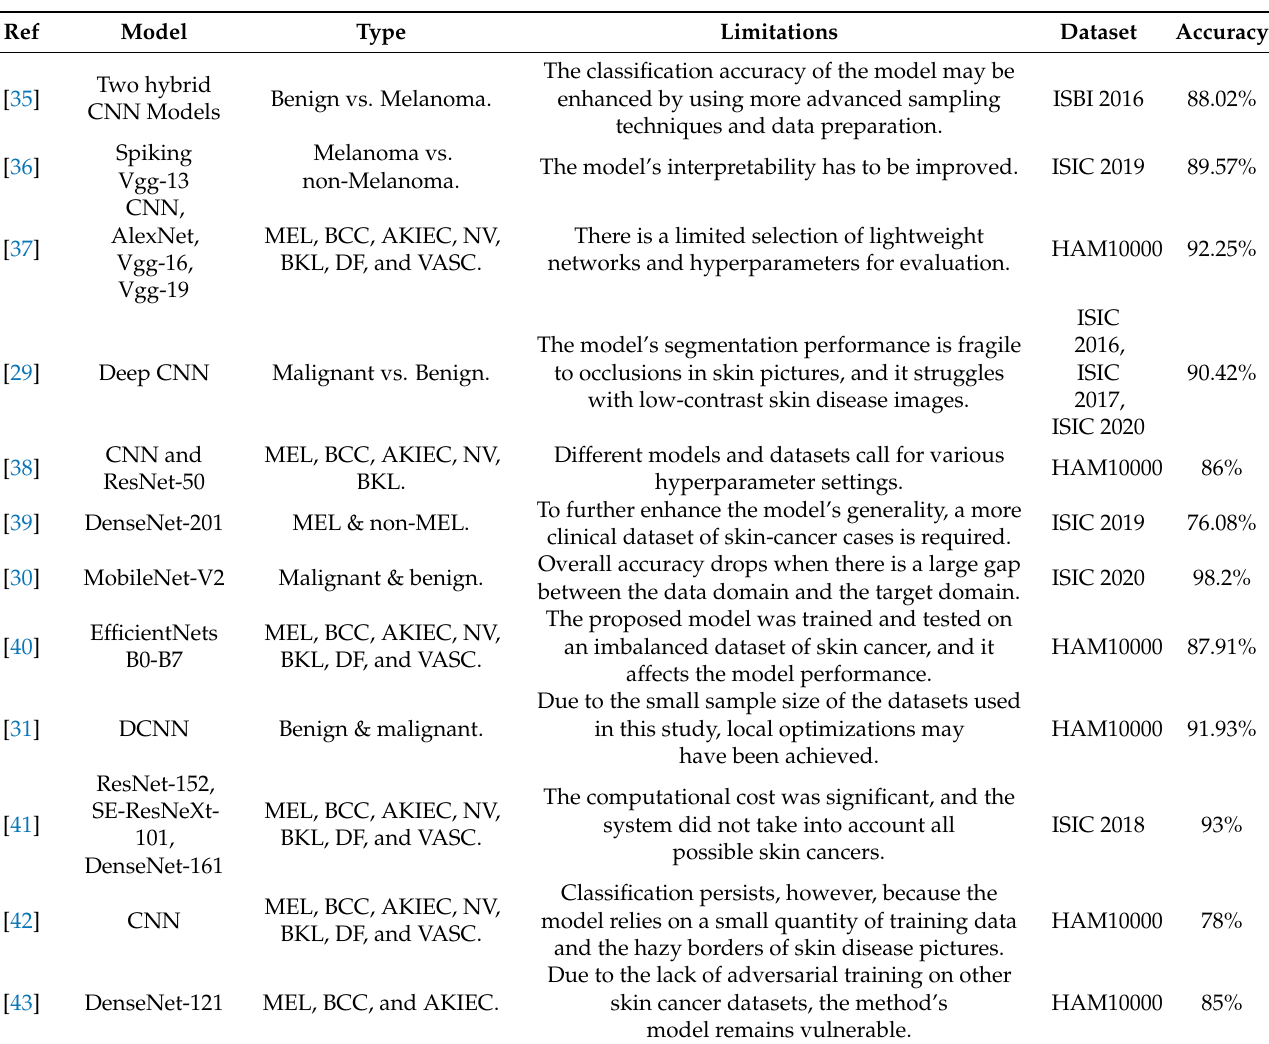
Table 1. Summary of the existing research studies for the diagnosis of skin cancer, using different machine learning and DL